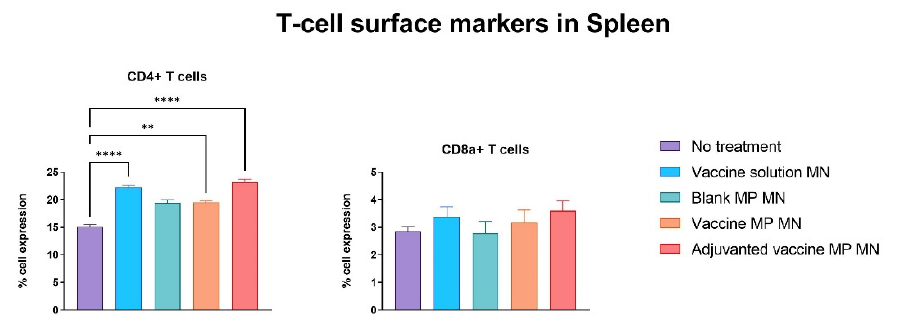
Figure 9. Assessment of T-cell surface markers in the spleen of immunized mice using flow cytometry. Mice were immunized via transdermal route with one prime dose on day 0 and two booster doses on days 15 and 29. Seven days post-challenge with live Zika virus, mice were sacrificed, and the spleens were extracted, processed into single-cell suspensions, and analyzed for the presence of T-cell surface markers. Samples from mice receiving vaccine solution, vaccine MPs, and adjuvanted vaccine MPs showed significantly higher expressions of CD4 cell surface markers than the control group. Expression of CD8a T-cell surface marker was not significant in spleen samples (data pre- sented as mean ± SEM, n = 5, One-Way ANOVA test followed by Dunnett’s multiple comparison test; **, p < 0.01, ****, p < 0.0001).